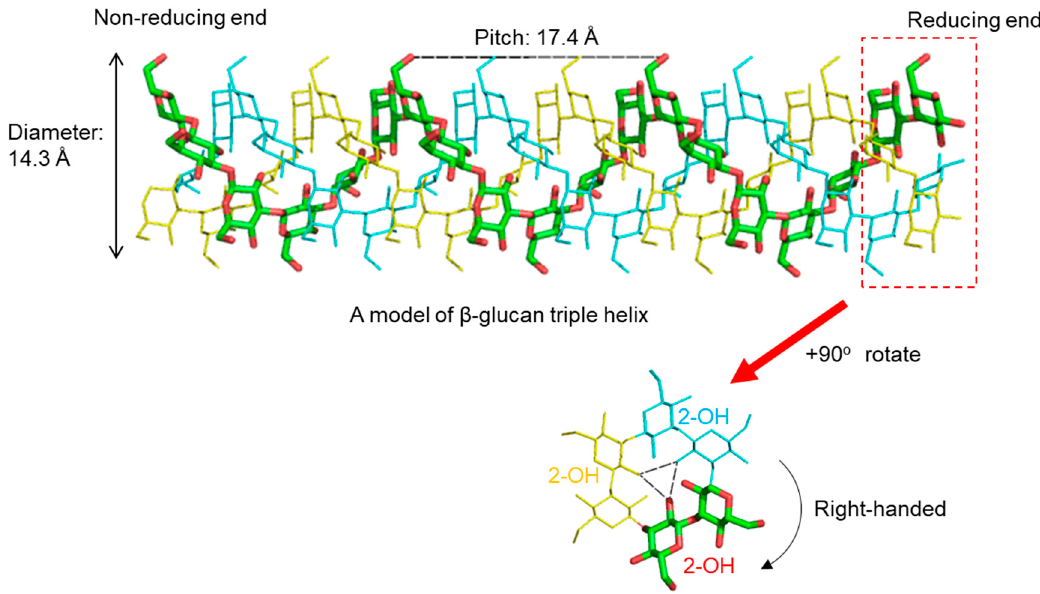
Figure 2. A model of right-handed triple helical β (1,3)-glucan based on X-ray diffraction data [11]. A pitch of helix is estimated as 17.4 Å and the diameter as 14.3 Å. Inter-strand hydrogen bonds are formed between 2-OH of glucose residues, which are perpendicular to the helix axis.